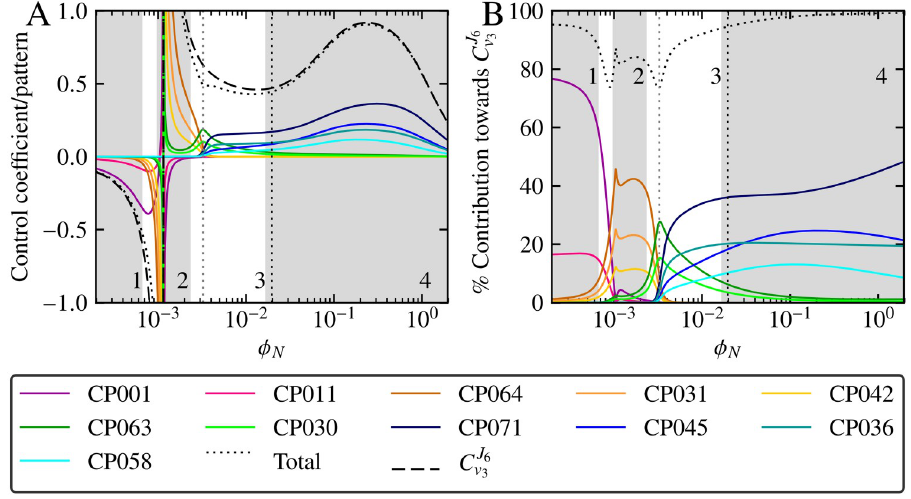
Fig 3. The most important control patterns of C J 6 as functions of ϕ N . Control patterns were chosen according to the v 3 and the criteria described in the text. (A) The most important control patterns shown in relation to the value of C J 6 v 3 value of their total sum. (B) The absolute percentage contribution of the most important control patterns relative to the absolute sum of the values of all C J 6 control patterns. Control patterns and C J 6 are indicated in the key. In both (A) and v 3 v 3 (B) grey shaded regions indicate ranges of ϕ N -values that are dominated by a group of related control patterns, while unshaded regions indicate shared contribution by unrelated patterns. Groups are numbered 1–4 (see Table 1), and control patterns belonging to a group are colour coded such that group 1 is pink, 2 is yellow, 3 is green, and 4 is blue. Control in the unshaded region 3 is shared between the group 2 and 3 patterns for ϕ < 0.0033 and by the group 3 and N 4 patterns for ϕ N > 0.0033 as indicated by the vertical dotted gray line. The switch from negative control coefficient values to positive values indicates indicates the reversal of direction of J 6 flux. The black dotted vertical line indicates the steady-state value of ϕ N in the reference